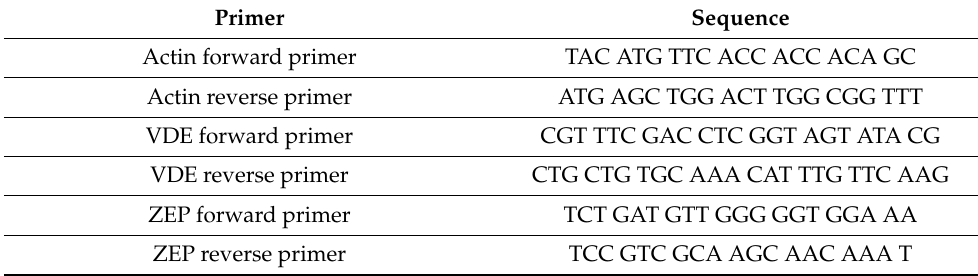
Table 3. Primers for gene expression